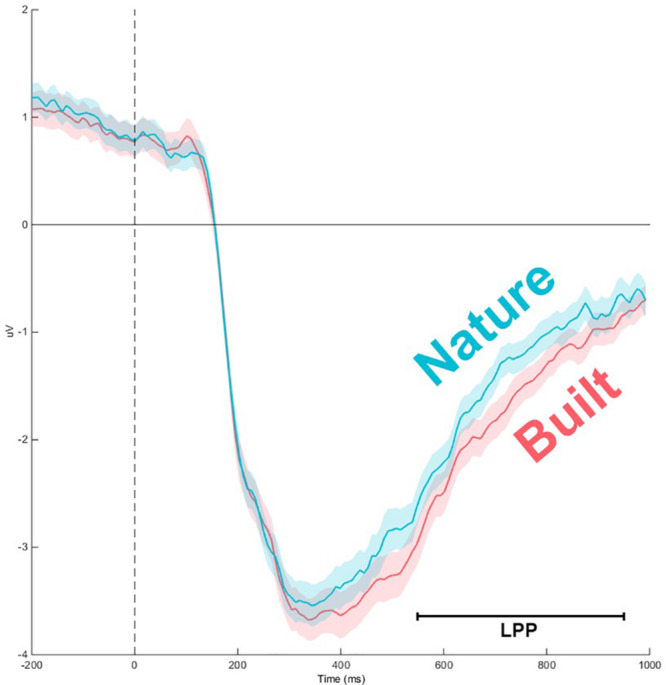
Event-related potentials time course for frontal channels (averaged). Main effect of Environment indicates natural stimuli to elicit lesser LPP mean amplitude than built stimuli in frontal channels [F(1,59) = 11.12; p < 0.005; ηp2 = 0.16]. Error shading represents 95% confidence interval.